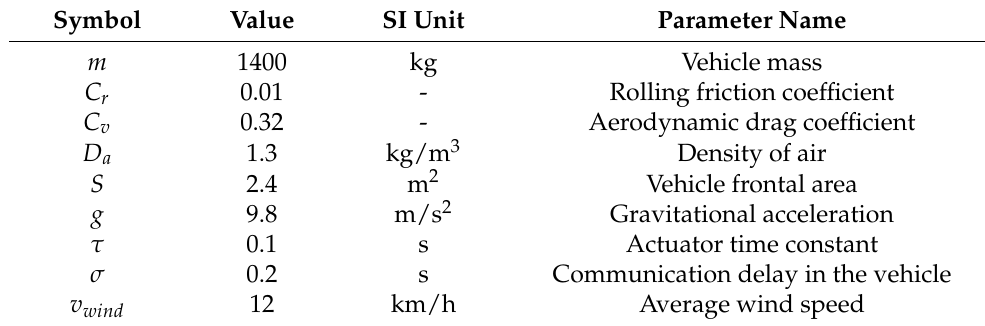
Table 1. Longitudinal dynamics